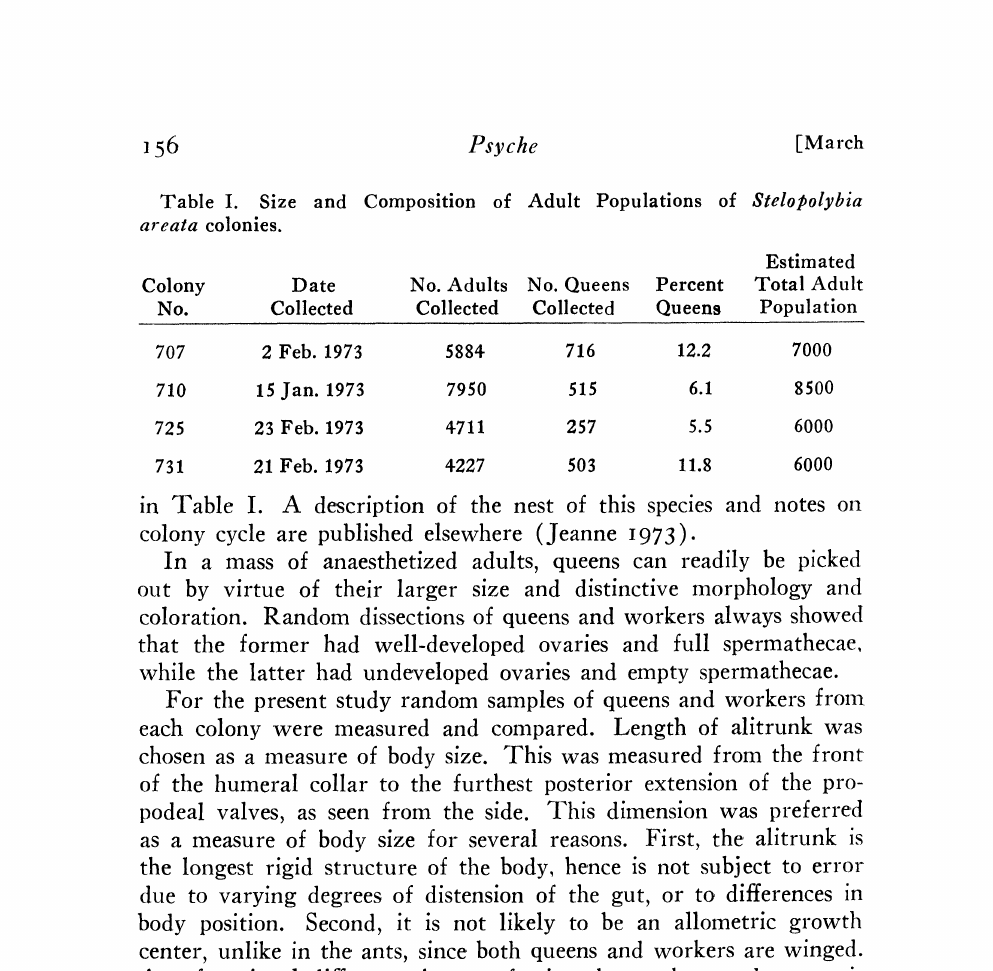
Table I. Size and Composition of Adult Populations of 8telopolybia areata